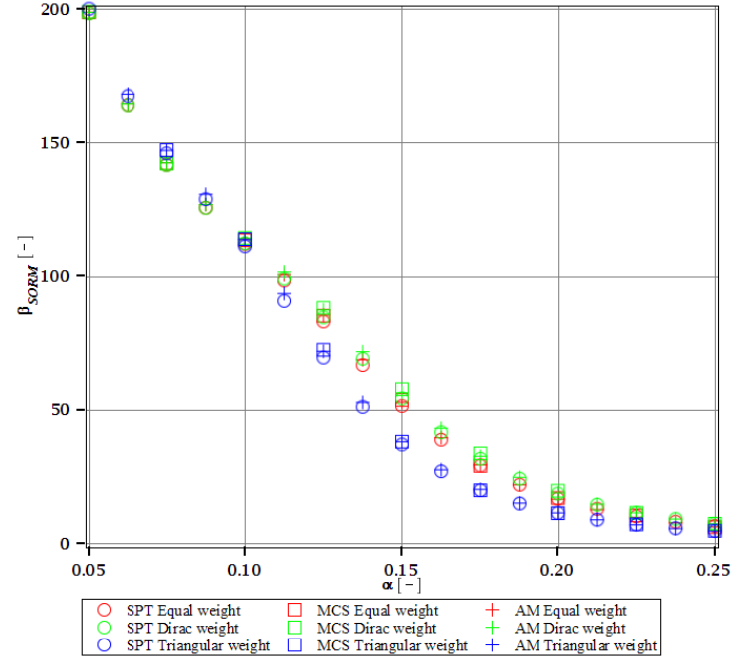
Figure 11. Kurtosis of the critical load for different types of weights.